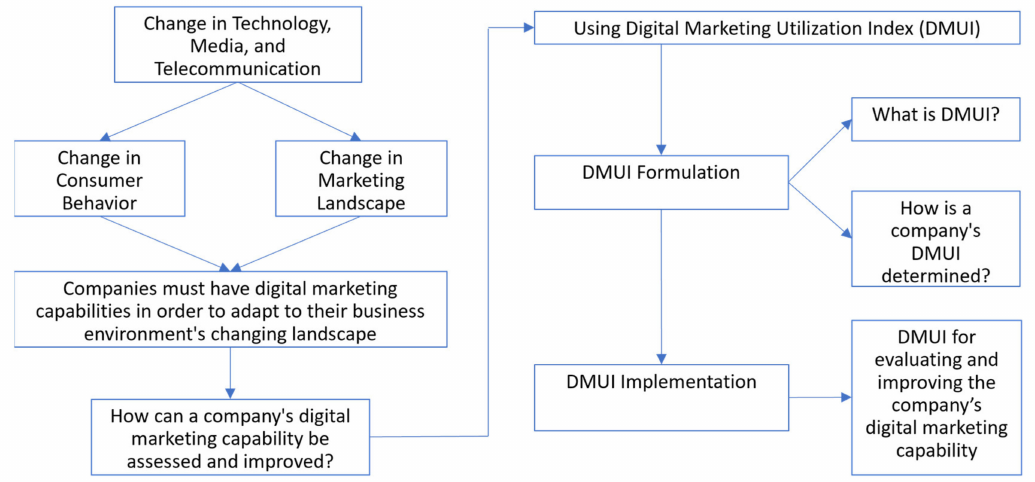
Figure 1. Research